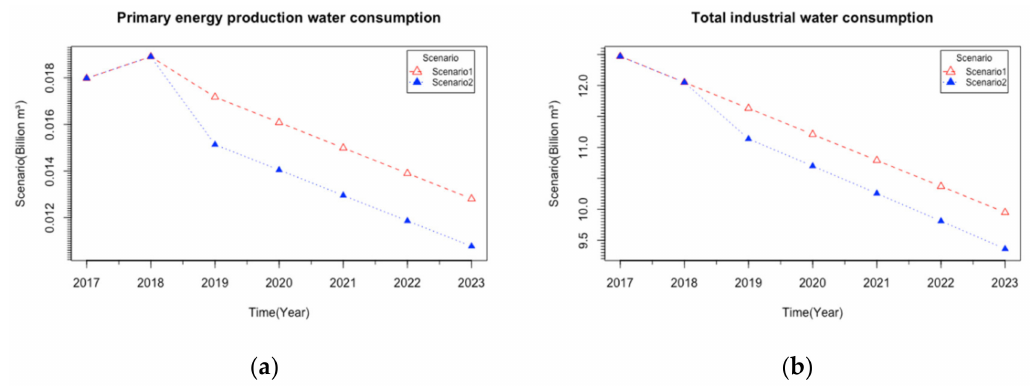
Figure 9. Scenario 2 simulation results: ( a ) Trend of primary energy production water consumption; ( b ) Trend of total industrial water